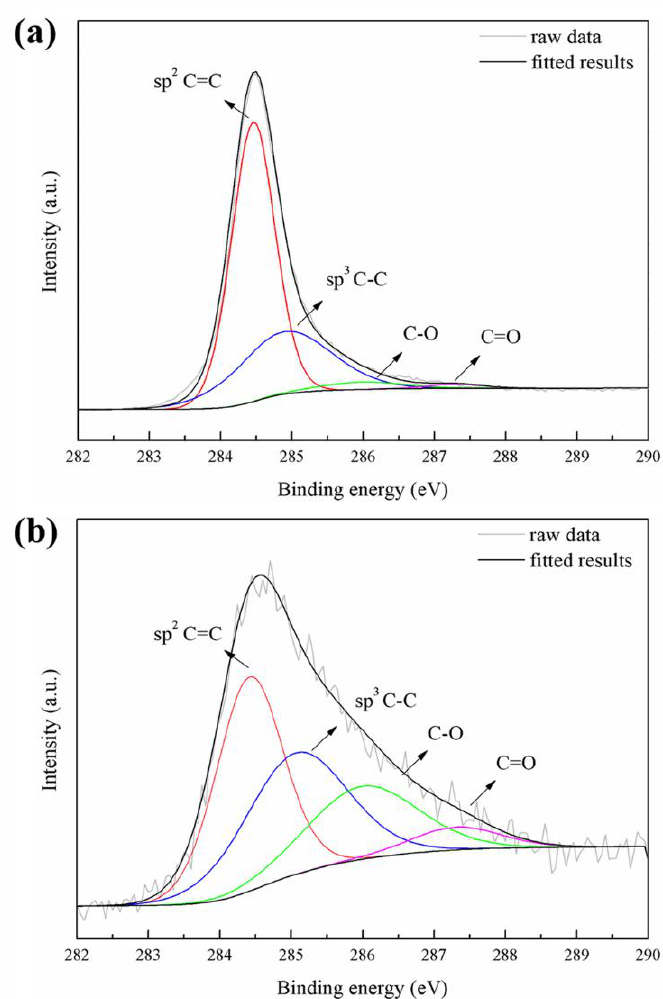
Figure 8. High-resolution XPS spectra of element-detected carbon: ( a ) pristine CNT and ( b ) 10 g/L CNT PEO-coated film.